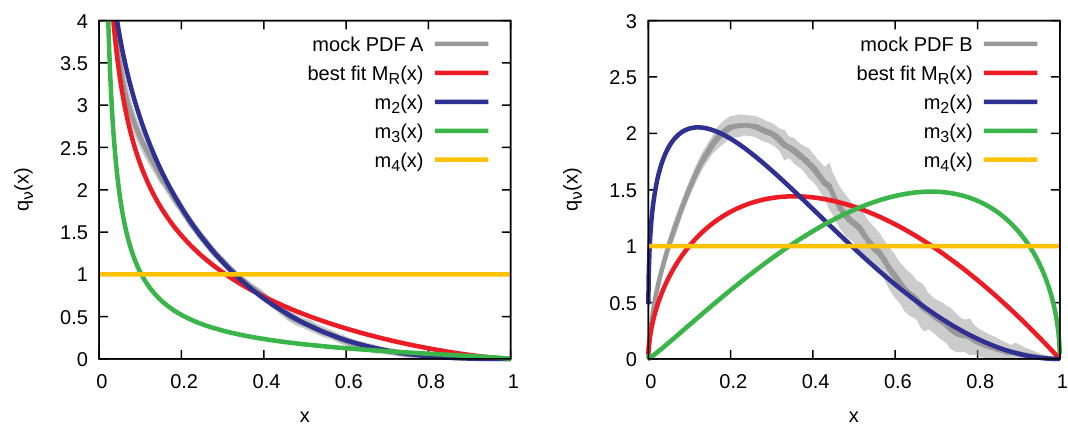
Figure 13 . Best (cid:12)t PDF (red solid line) from (left) realistic PDF data [mock scenario A] and (right) a modi(cid:12)ed scenario with the PDF vanishing at the origin [mock scenario B]. The actual mock PDF in the former cases is given as gray solid line. To determine the dependence of our results on the choice of default model, three further choices for m are plotted, two arising from varying the best (cid:12)t parameters by factors of 2, one being the constant default model